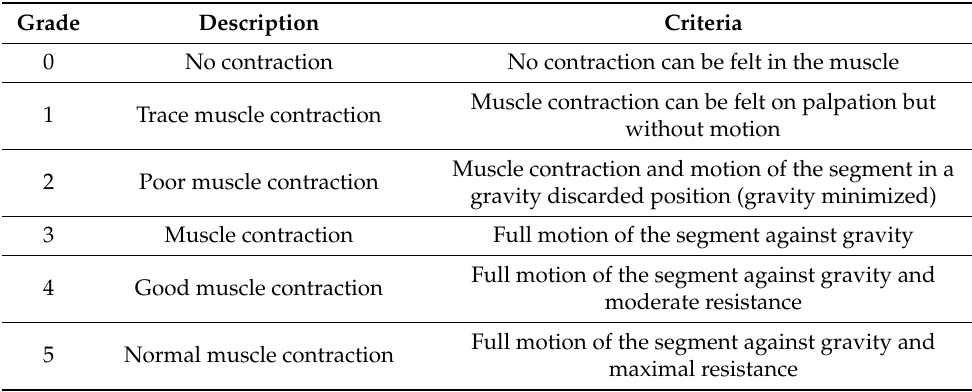
Table 1. The classical Manual Muscle Testing scoring